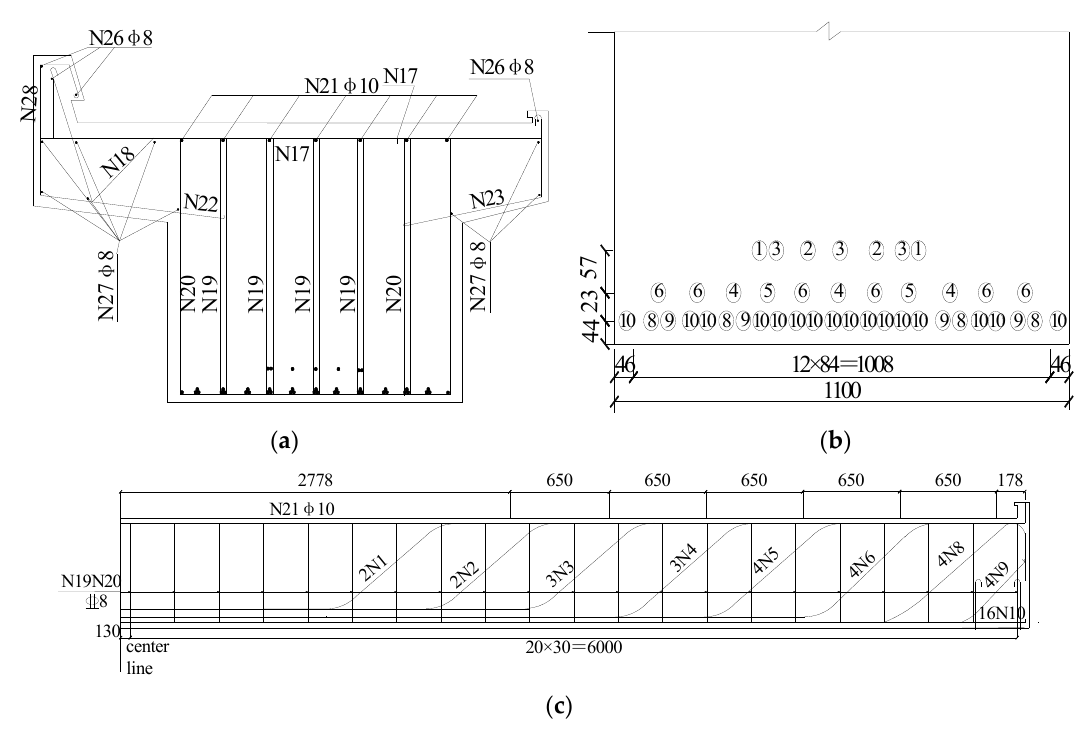
Figure 5. Detailing of steel bars. ( a ) Midspan section; ( b ) stressed steel bars of midspan section; ( c ) center half section of beam stem (unit: mm).